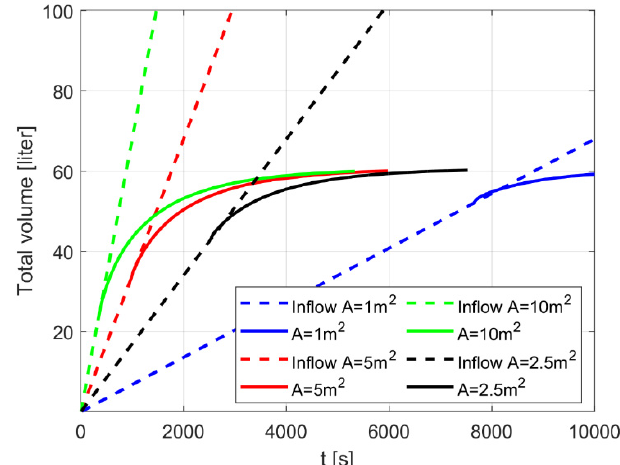
Figure 13. Comparisons of cumulative rainfall volumes and Up-flow SPB (Up3) storage filling (black solid line) for a constant rate of inflow (SW region) and various runo ff contributing areas: blue—1 m 2 , black—2.5 m 2 , red—5 m 2 , green—10 m 2